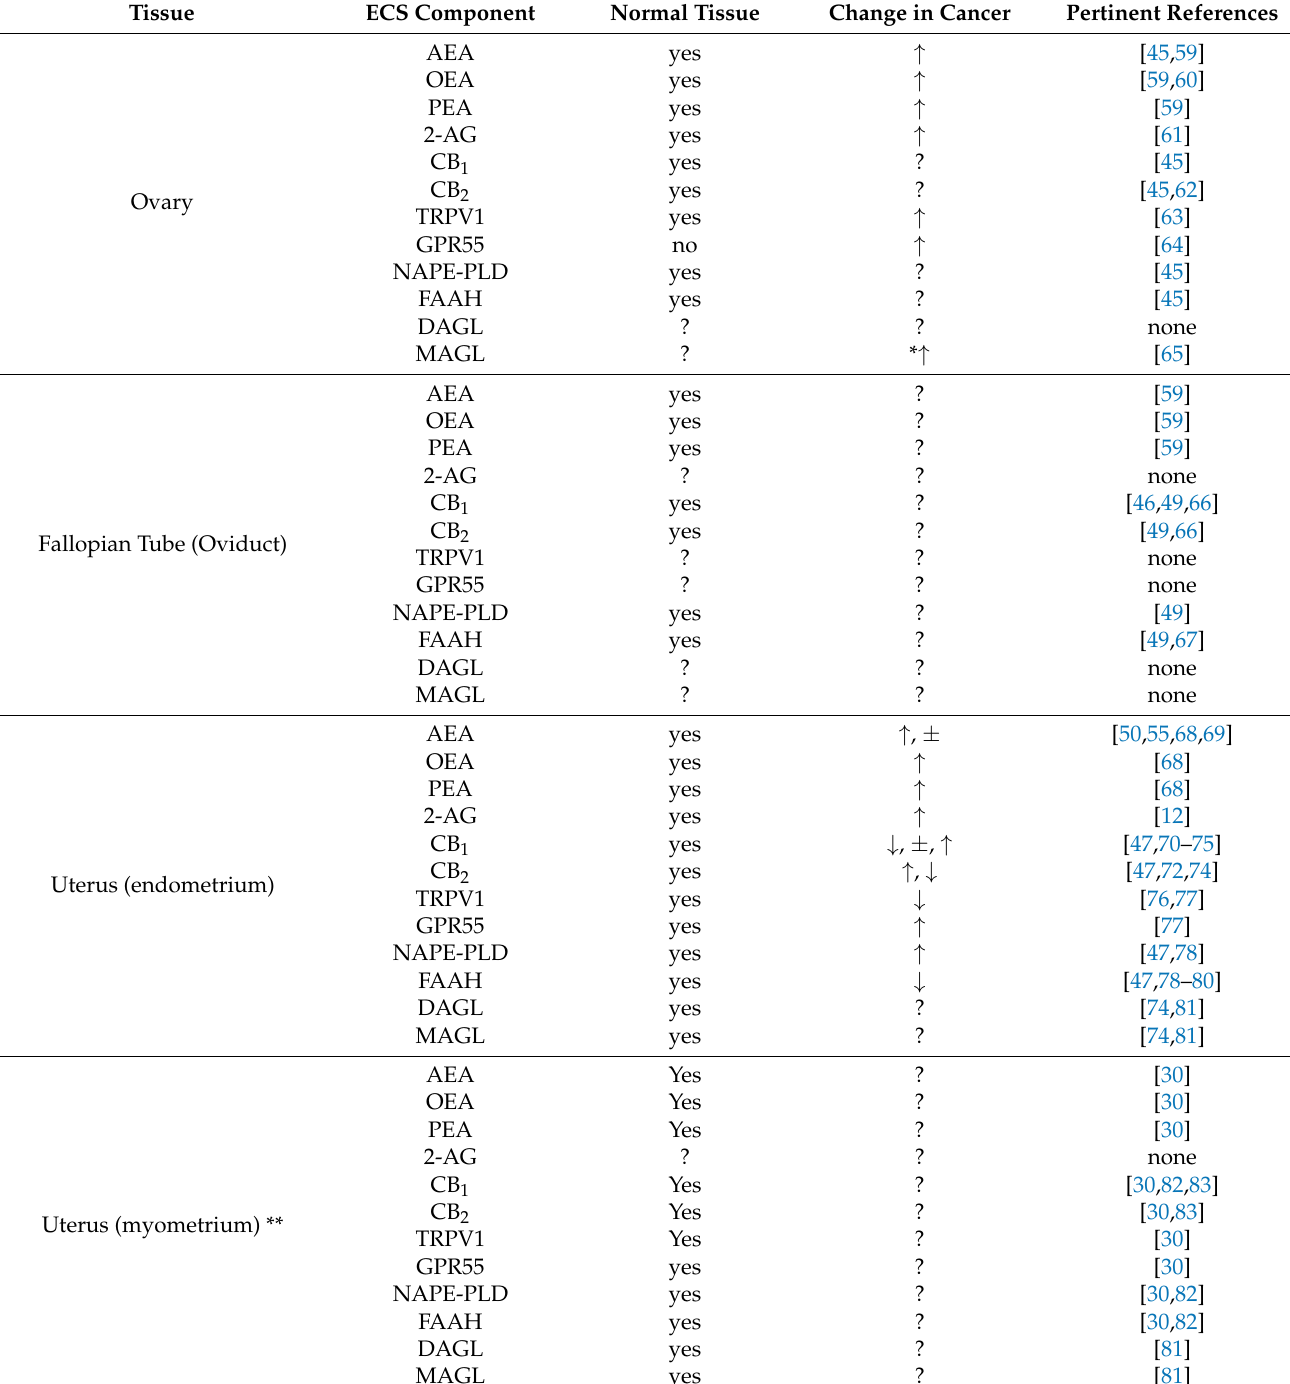
Table 1. Summary of the main ECS components in the female reproductive